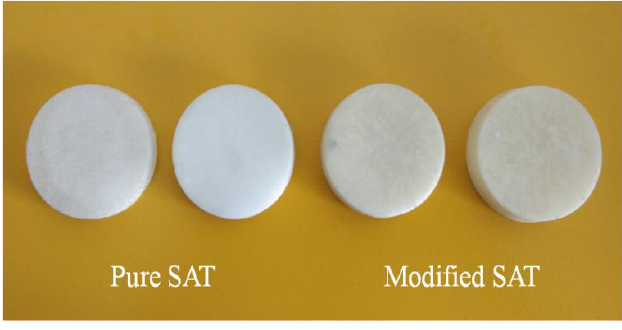
Figure 9. Solid SAT samples.